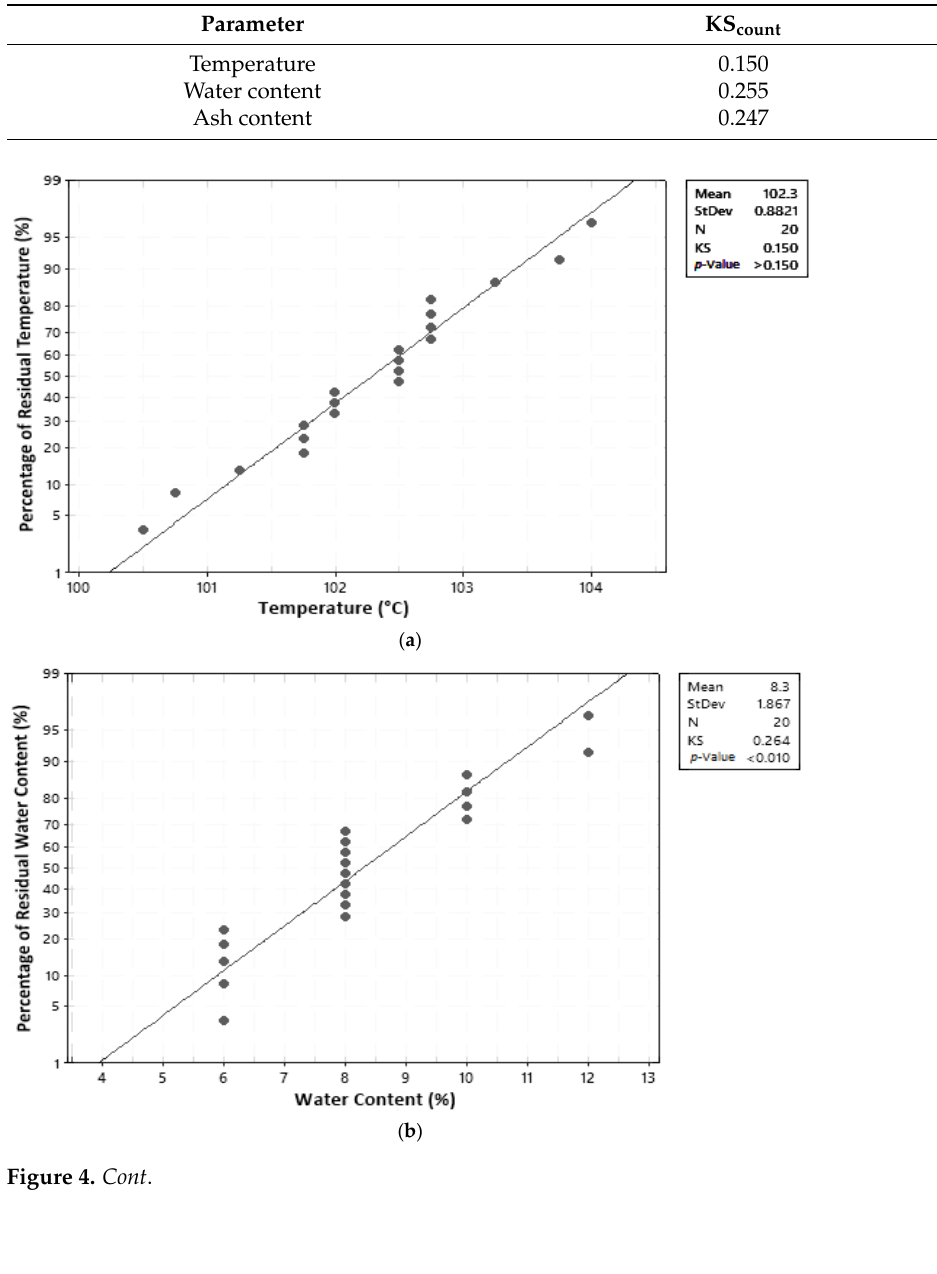
Table 6. Normal distribution assumption test results.